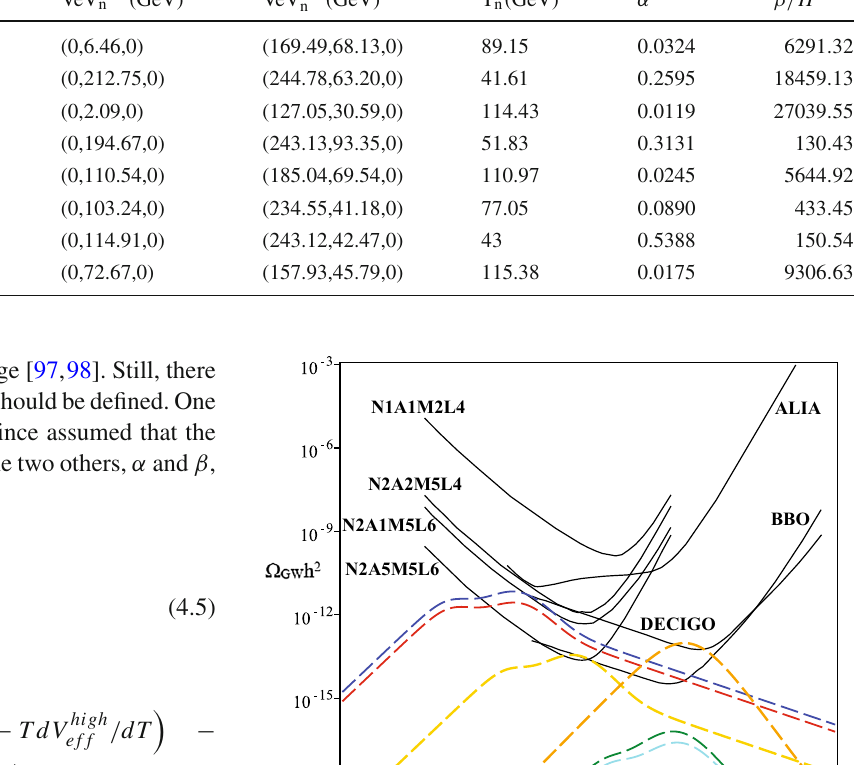
According to the Tables 2 and 3, it seems that BM2 is a special point. The value of β/ H is large at this point, while, the nucleation temperature is not very close to the critical temperature. At the same time, T n is low and α is large. 5 To clarify the situation of BM2, the phase transition properties of BM2 are shown in Fig. 2. As seen from the Fig. 2a, the slope of S 3 / T increases around T n which indi- cates the parameter β/ H is large. The physics of this